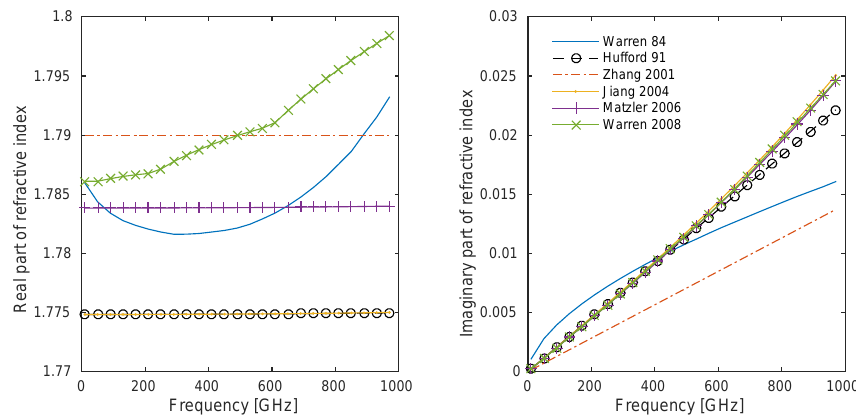
Figure 1. Real (left) and imaginary (right) part of the refractive index of pure ice as a function of frequency, according to Warren (1984), Hufford (1991), Zhang et al. (2001), Jiang and Wu (2004), Mätzler (2006) and Warren and Brandt (2008). The temperature is set to 266K.